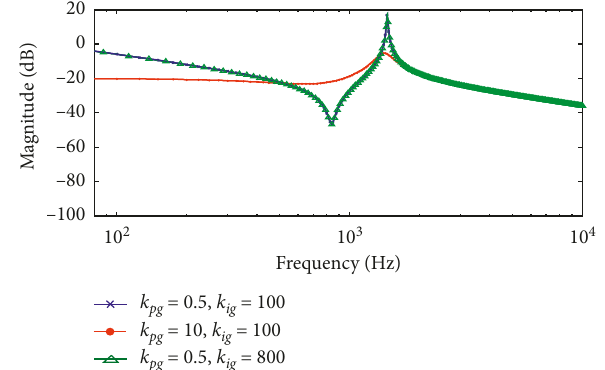
Figure 7: Magnitude-frequency curves of Y